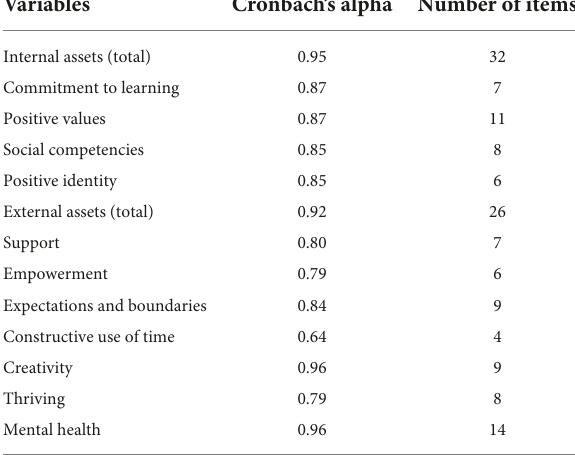
TABLE 1 Reliability test for developmental assets, creativity, thriving, and mental